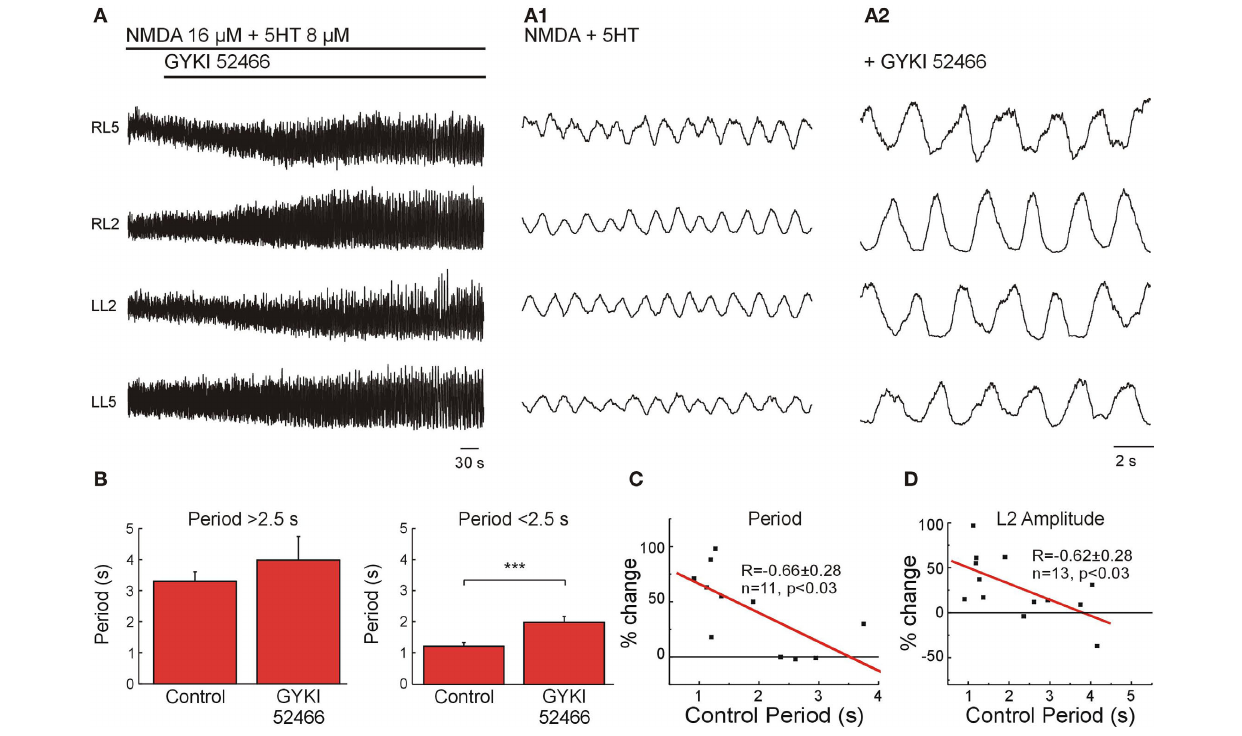
Figure 4 | AMPArs intrinsic to the network are necessary for generation of a high frequency locomotor-like activity. (A) Effect of GYKI 52466 (20 μM) on locomotor-like activity at high frequency. VR activity was recorded in AC mode in RL2/RL5 and in DC mode in LL2/LL5. Expansions show VR activity before blockers (A1) and after full effect of GYKI 52466 (A2) . (B) Statistical analysis of the effect of GYKI 52466 on moderate (left; n = 8, not significantly different) and high locomotor frequencies (right, n = 8, *** p < 0.001). (C) Plot of the difference in locomotor